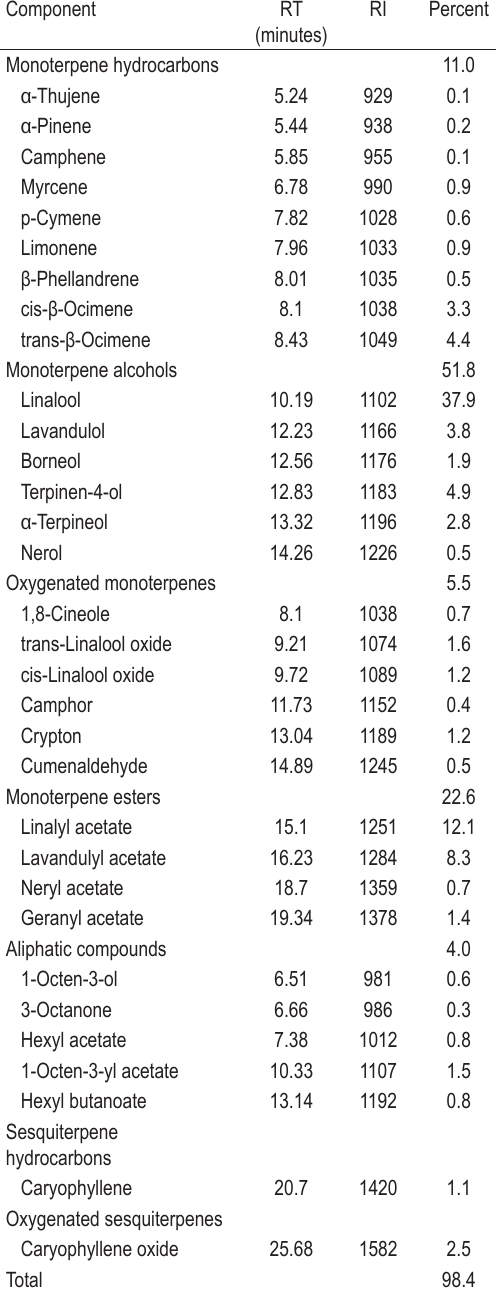
TABLE 2. Chemical composition of Lavanda angustifolia